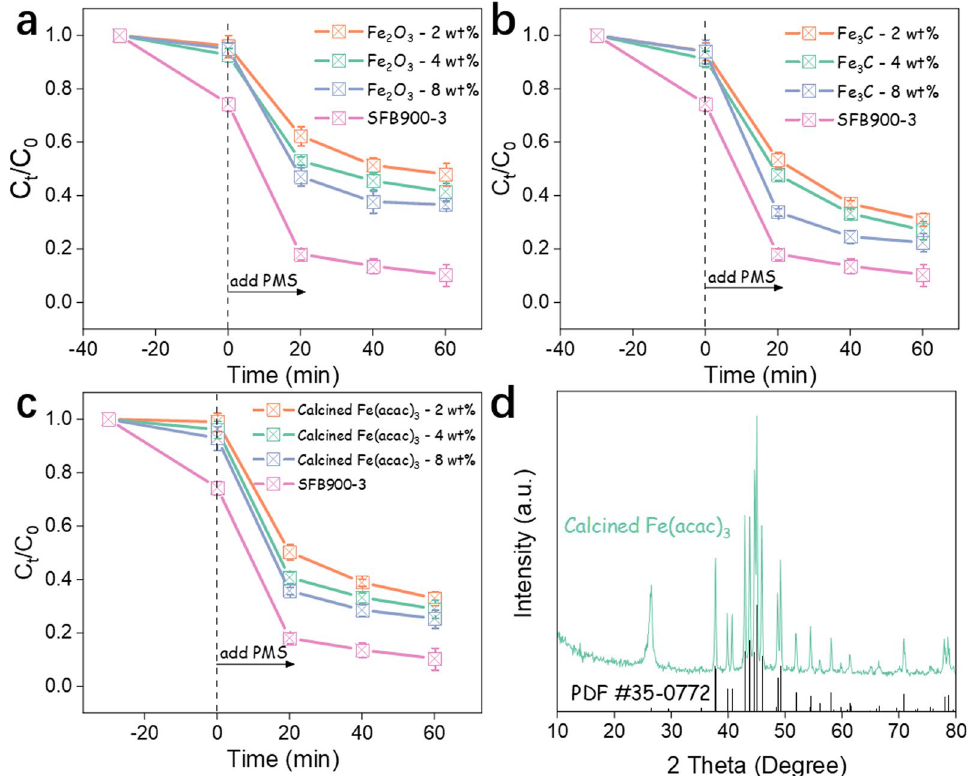
Fig. 4 SFB900-0/PMS system for NTP removal after supplemented with different amounts ( a ) Fe 2 O 3 , ( b ) Fe 3 C and ( c ) calcined Fe(acac) 3 . d XRD pattern of calcined Fe(acac) 3 . Conditions: [Biochar]